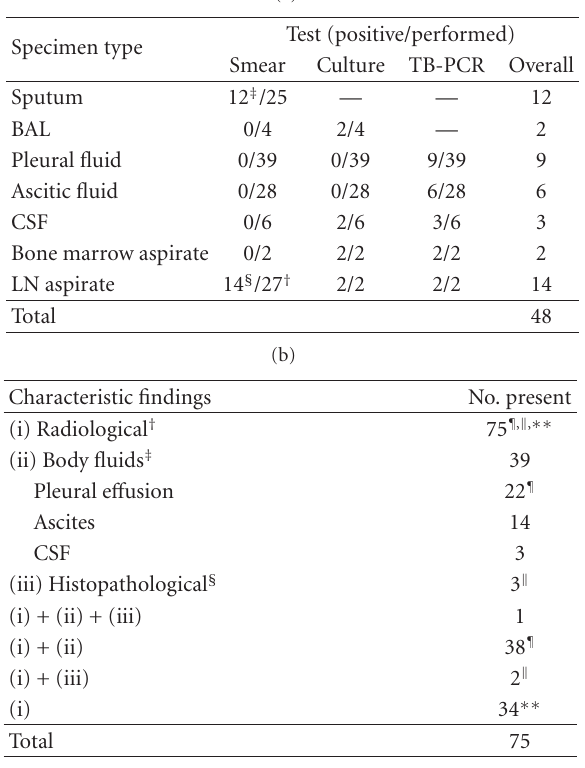
Table 3: (a) Method of “definitive ∗ ” TB diagnosis in HIV-TB group. ∗ Mycobacterium tuberculosis demonstrated in smear and/or culture and/or TB—polymerase chain reaction (PCR) positive in body fluids. PCR: polymerase chain reaction; BAL: bronchoalveolar lavage; CSF: cerebrospinal fluid; LN: lymph node. † In 25 cases fine needle aspiration was done, 12 of these showed Mycobacterium tuberculosis. ‡ One patient from this group developed paradoxical TB-IRIS. § One patient from this group developed paradoxical TB-IRIS. (b) Method of “probable ∗ ” TB diagnosis in HIV-TB group. ∗ Specimens for smear or culture or PCR for Mycobacterium tuberculosis negative or could not be obtained. † High resolution or contrast-enhanced computed tomography (CECT) of chest showing—centrilobular nodules with tree-in-bud appearance, mil- iary nodules, thick walled cavities, enlarged mediastinal lymph nodes with central hypodensities and peripheral rim enhancement suggestive of necrosis; CECT of abdomen showing enlarged liver or spleen with multiple hypodensities suggestive of granulomas or abscesses, matted bowel loops, thickening of terminal ileum and caecum, enlarged necrotic mesenteric or retroperitoneal lymph nodes; CECT and/or magnetic resonance imaging (MRI) of brain showing basal meningitis and/or multiple ring enhancing lesion suggestive of tuberculomas; MRI of spine showing loss of intervertebral space with destruction of vertebral bodies with or without paravertebral abscesses. ‡ Elevated protein, predominantly lymphocytes and high adenosine deaminase level. § FNAC or biopsy showing granulomas with caseation necrosis. ¶ , (cid:3) , ∗∗ One patient each from these groups developed paradoxical